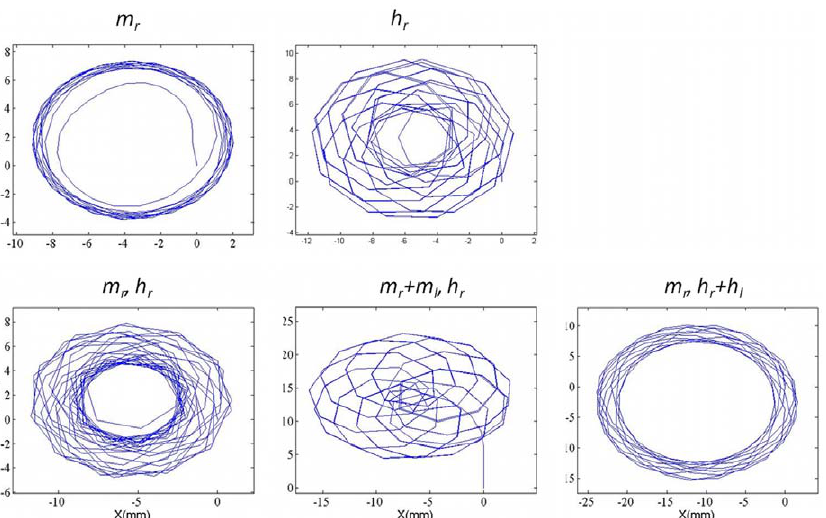
Figure 7. Circling trajectories from swimming simulations. The circular trajectories obtained from the swimming simulations are illustrated above. Based on the simulations, only three beating patterns stabilized to form a consistent circular trajectory, the middle right leg only ( m r ), the middle right followed by the hind right ( m r , h r ), and the middle right followed by the simultaneous beating of the hind legs ( m r , h r + h l ). The other beating patterns analyzed produced unstable trajectories, resulting in trajectories not observed in nature. Numerical analysis of the circular swimming trajectories is shown in Table 5 .